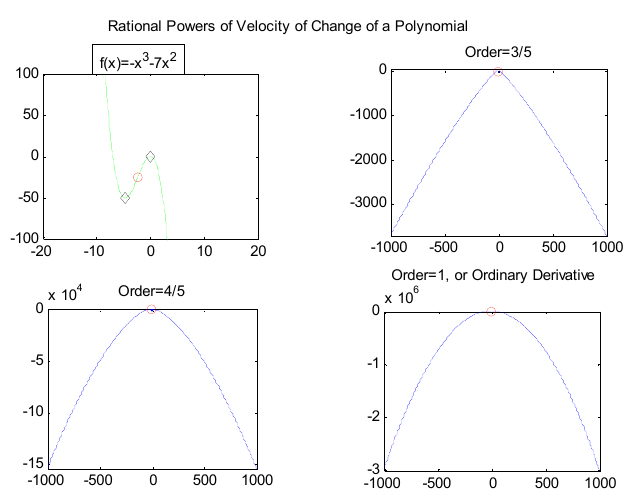
Figure 8. The rates of change for f ( x ) = − x 3 − 7 x 2 orders {0, 1/5, 2/5}.